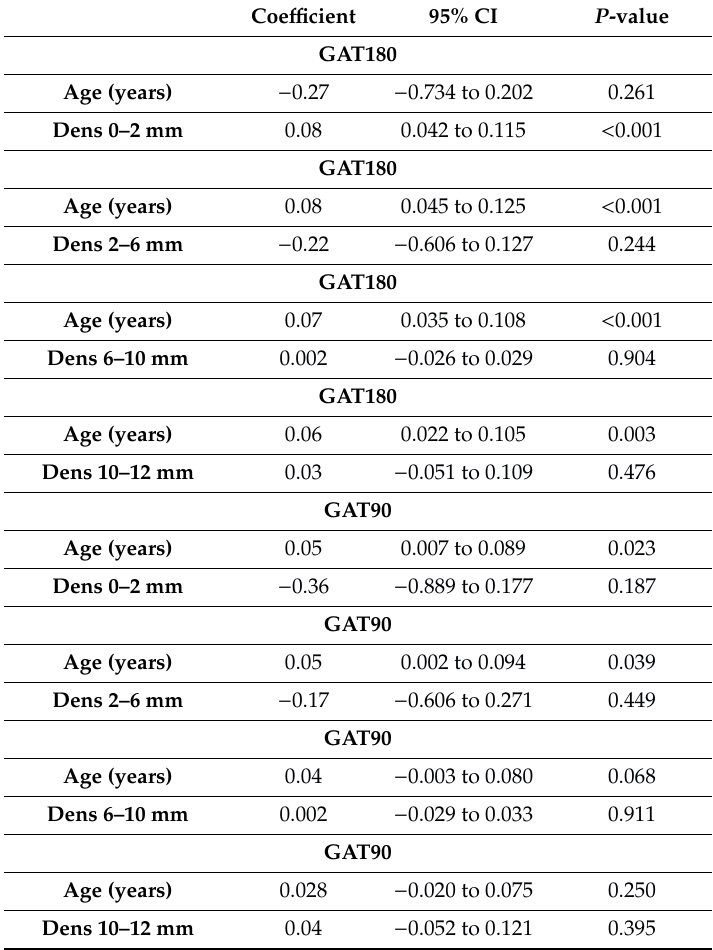
Table 4. Multivariable regression analysis examining the relationship between IOP from GAT180 and GAT90 and corneal densitometry, accounting for